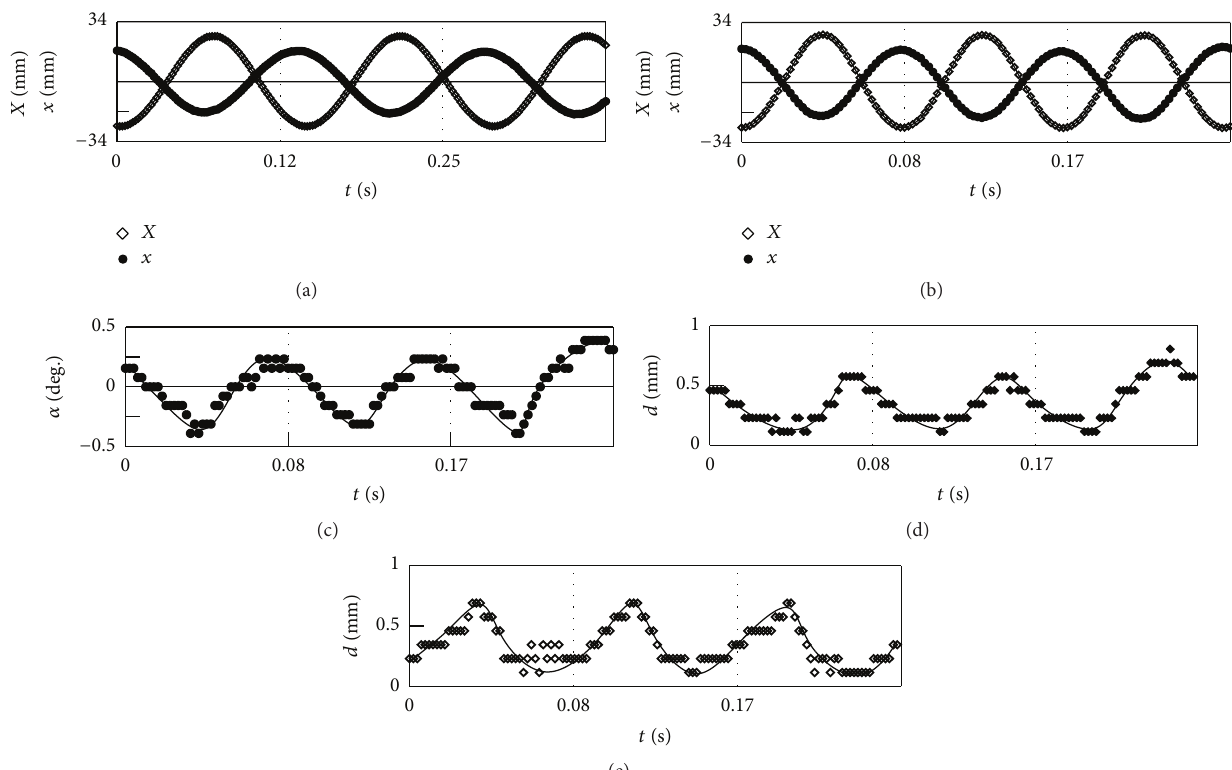
Figure 5: Characteristics of the body oscillations before (a) and after repulsion from the bottom